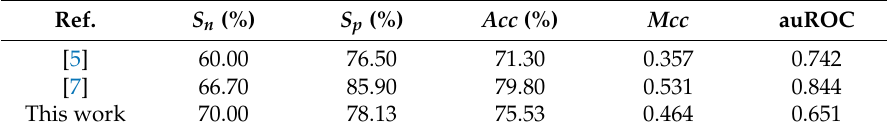
Table 3. Comparing the proposed method with other published methods on the independent dataset.